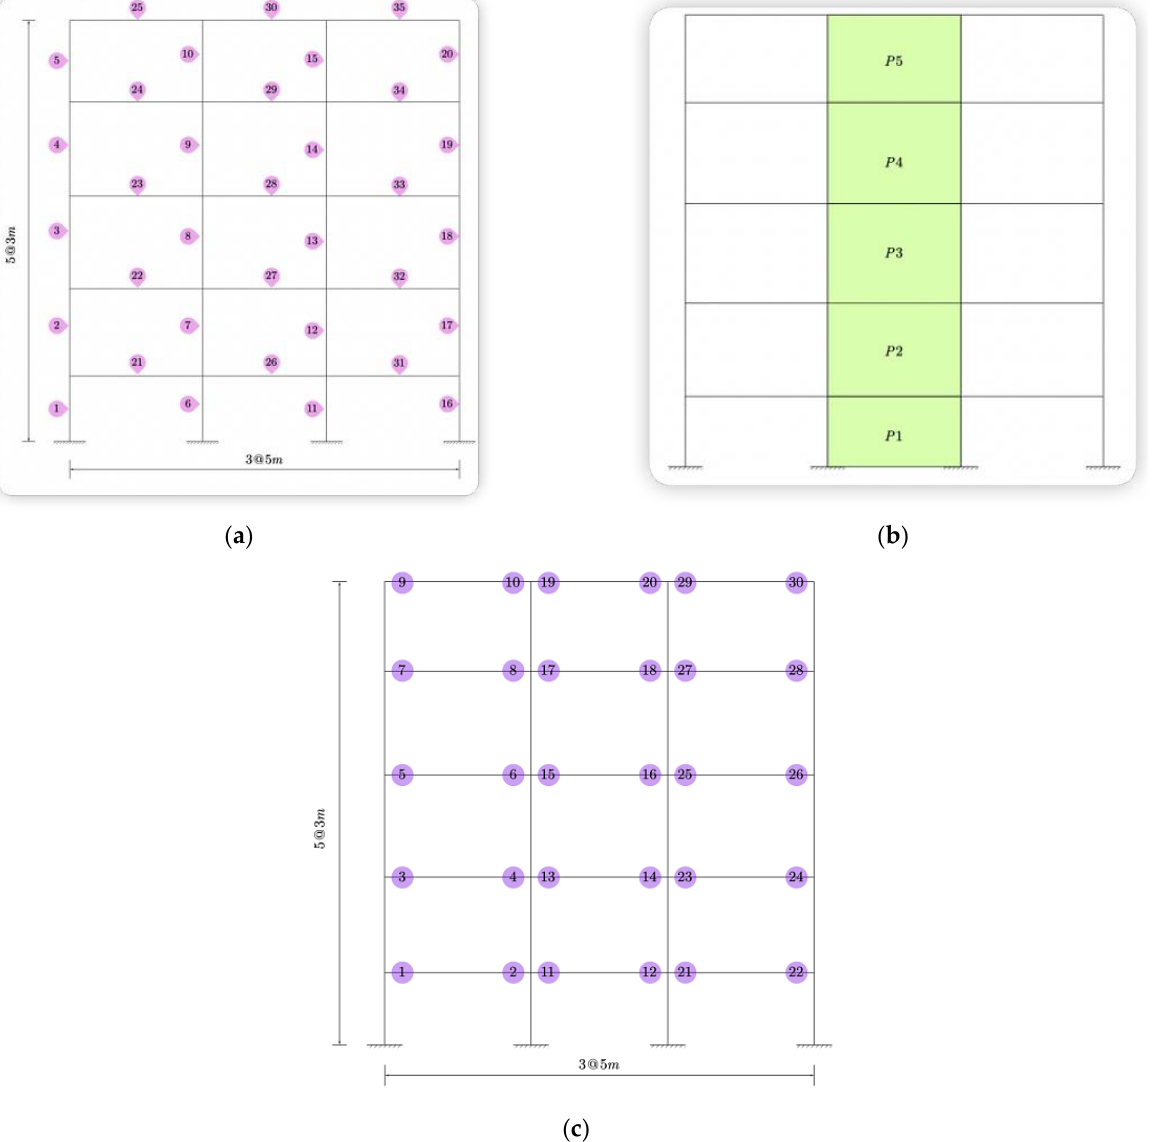
Figure 10. ( a – c ). Dimensions of the structure and the infilled plates placement with the numbering of semirigid